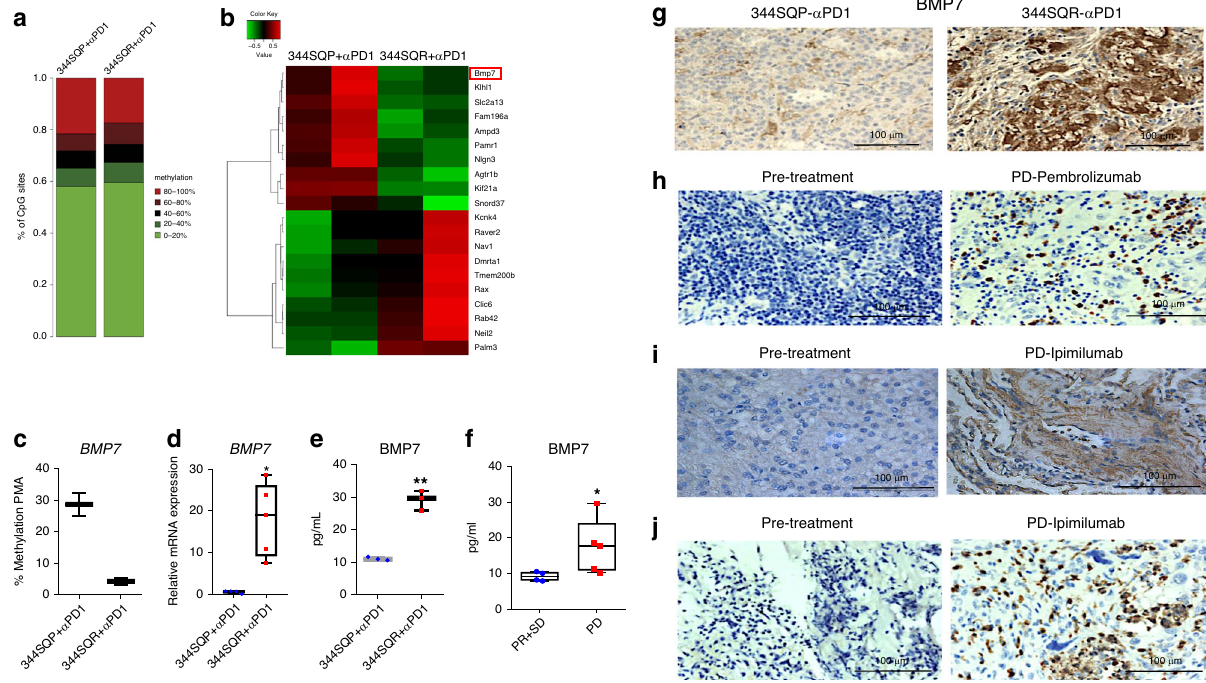
Fig. 1 BMP7 is upregulated in tumors resistant to immunotherapies. a , b Reduced representation bisul fi te sequencing (RRBS) results from 344SQP (parental) ( n = 2 biologically independent samples) and 344SQR (anti-PD1-resistant) ( n = 2 biologically independent samples) tumors treated with anti-PD1 (10 mg/kg). a Percentages of CpG sites methylation and b heatmap of top 10 hypomethylated (green) and 10 hypermethylated (red) genes in 344SQP ( n = 2 biologically independent samples) and 344SQR ( n = 2 biologically independent samples) tumors treated with anti-PD1(10mg/kg). The methylation percentages for CpG sites were calculated by the bismark_methylation_extractor script from Bismark and an in-house Perl script. the differential methylation on CpG sites was statistically assessed by R/Bioconductor package methylKit (version 0.9.5). The CpG sites with read coverage ≥ 20 in all the samples were quali fi ed for the test. The signi fi cance of differential methylation on gene level was calculated using Stouffer ’ s z score method by combining all the quali fi ed CpG sites inside each gene ’ s promoter region (de fi ned as − 1000bp to + 500 of TSS), and was corrected to FDR by Benjamini & Hochberg (BH) method. c Pyrosequencing methylation assay with speci fi c primers for BMP7 CpG in 344SQP ( n = 2 biologically independent samples with three technical replicates for each sample) and 344SQR ( n = 2 biologically independent samples with three technical replicates for each sample) tumors treated with anti-PD1(10mg/ kg). Box-and-whisker plots show the minimum and maximum values. d Quantitative polymerase chain reaction (PCR) analysis of BMP7 expression in 344SQP ( n = 4 biologically independent samples with two technical replicates for each sample) and 344SQR ( n = 5 biologically independent samples with two technical replicates for each sample) tumors treated with anti-PD1 (10mg/kg). ACTB expression was used as a housekeeping gene for quantitative PCR analysis. The comparative Ct method was used to calculate the relative abundance of mRNAs compared with ACTB expression. Box-and-whisker plots show the minimum and maximum. ** p = 0.0159, two-sided Mann – Whitney test. e Enzyme-linked immunosorbent assay of BMP7 levels in serum from mice bearing 344SQR ( n = 3 biologically independent samples with two technical replicates for each sample) or 344SQP ( n = 3 biologically independent samples with two technical replicates for each sample) tumors treated with anti-PD1(10mg/kg). Box-and-whisker plots show the minimum and maximum. ** p = 0.0080 unpaired, two-sided t tests. f Enzyme-linked immunosorbent assay for BMP7 in pretreatment plasma collected from patients with disease that progressed (PD) ( n = 5 biologically independent samples) on pembrolizumab (NCT02444741; NCT02402920) versus patients with progressive response (PR) or stable disease (SD) ( n = 4 biologically independent samples). Box-and-whisker plots show the minimum and maximum. * p = 0.0317, two-sided Mann – Whitney test. g Representative images of immunohistochemical stains of BMP7 expression in formalin- fi xed paraf fi n-embedded tissue sections from 344SQP and 344SQR tumors treated with anti-PD1. Data shown are representative of two reproducible independent experiments. Scale bar, 100 μ m (×40 magni fi cation). h – j Representative images of immunohistochemical stains of BMP7 expression in formalin- fi xed paraf fi n-embedded tissue sections collected from patients with NSCLC, adrenocortical carcinoma, and mixed Mullerian carcinoma before and at the time of disease progression on pembrolizumab or ipimilumab. Data shown are representative of two reproducible independent experiments. Scale bar, 100 μ m (×40magni fi